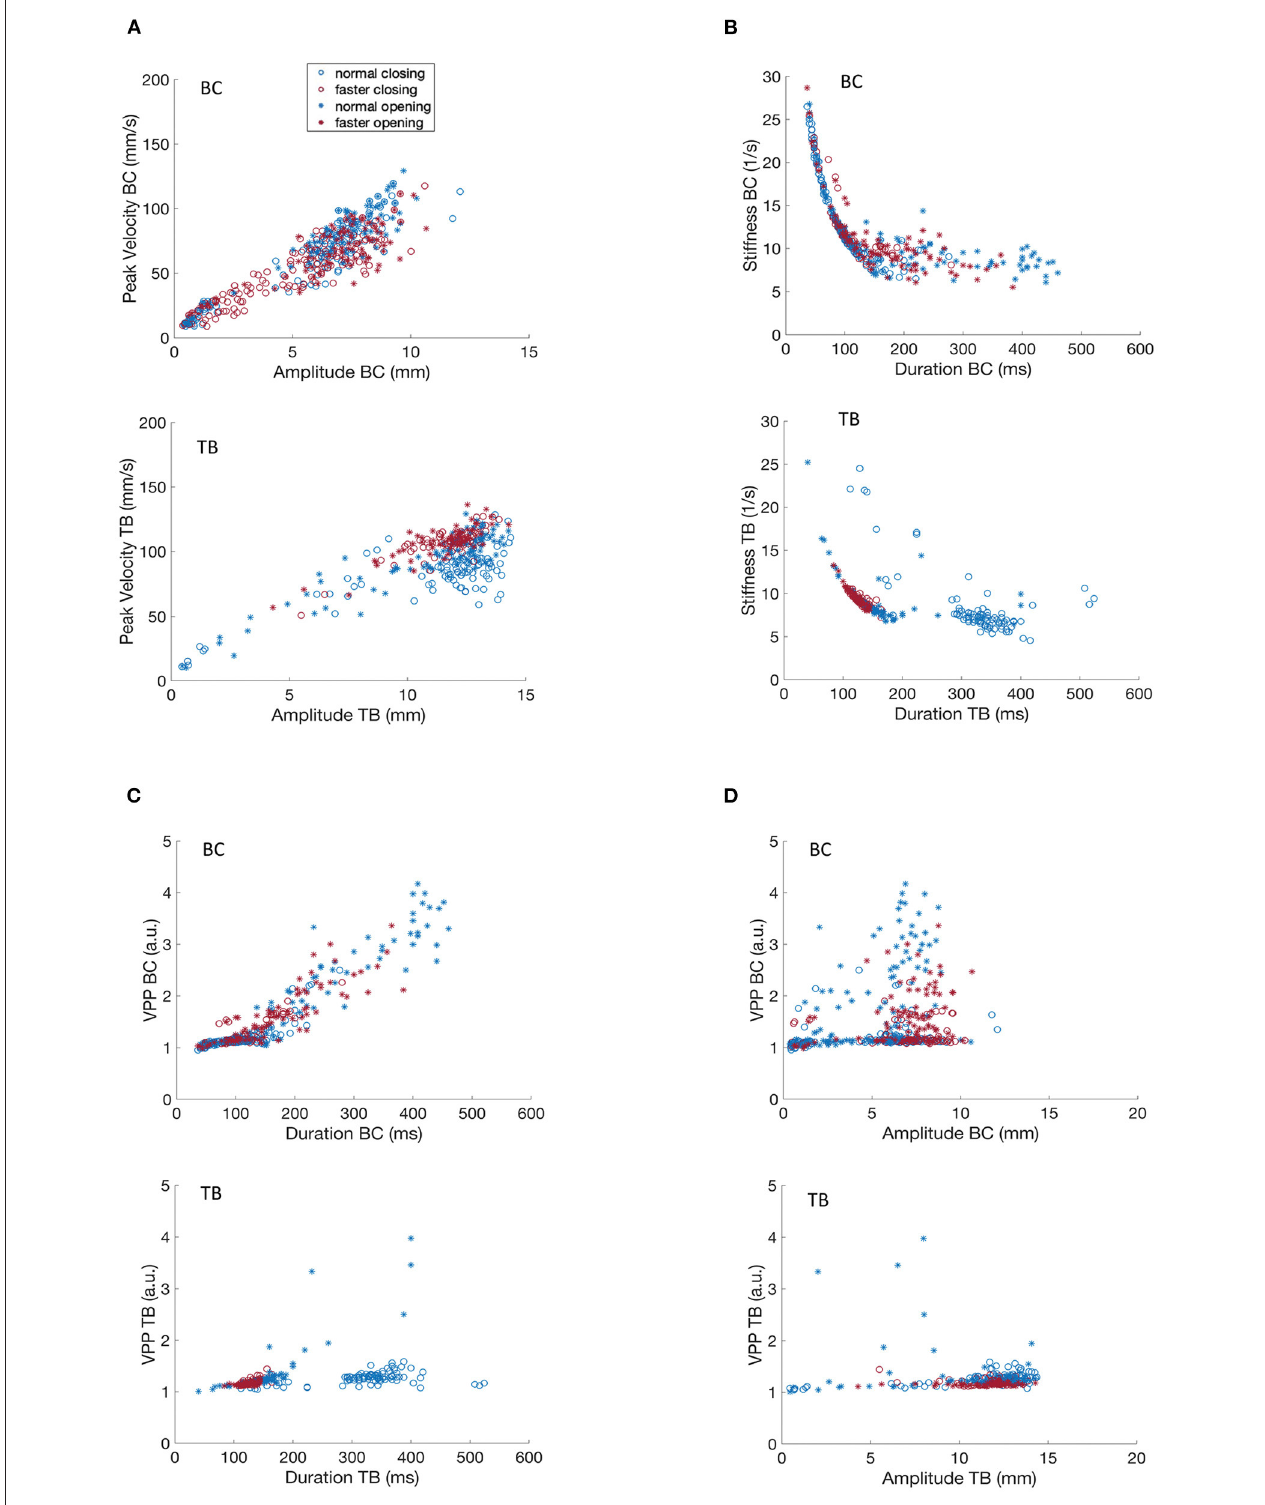
FIGURE 2 | Covariation of kinematic parameters of BC and TB gestures for participant M1 for productions of [ipa]. (A) Peak velocity vs. movement amplitude. (B) Stiffness vs. duration. (C) Velocity profile parameter vs. duration. (D) Velocity profile parameter vs. amplitude.